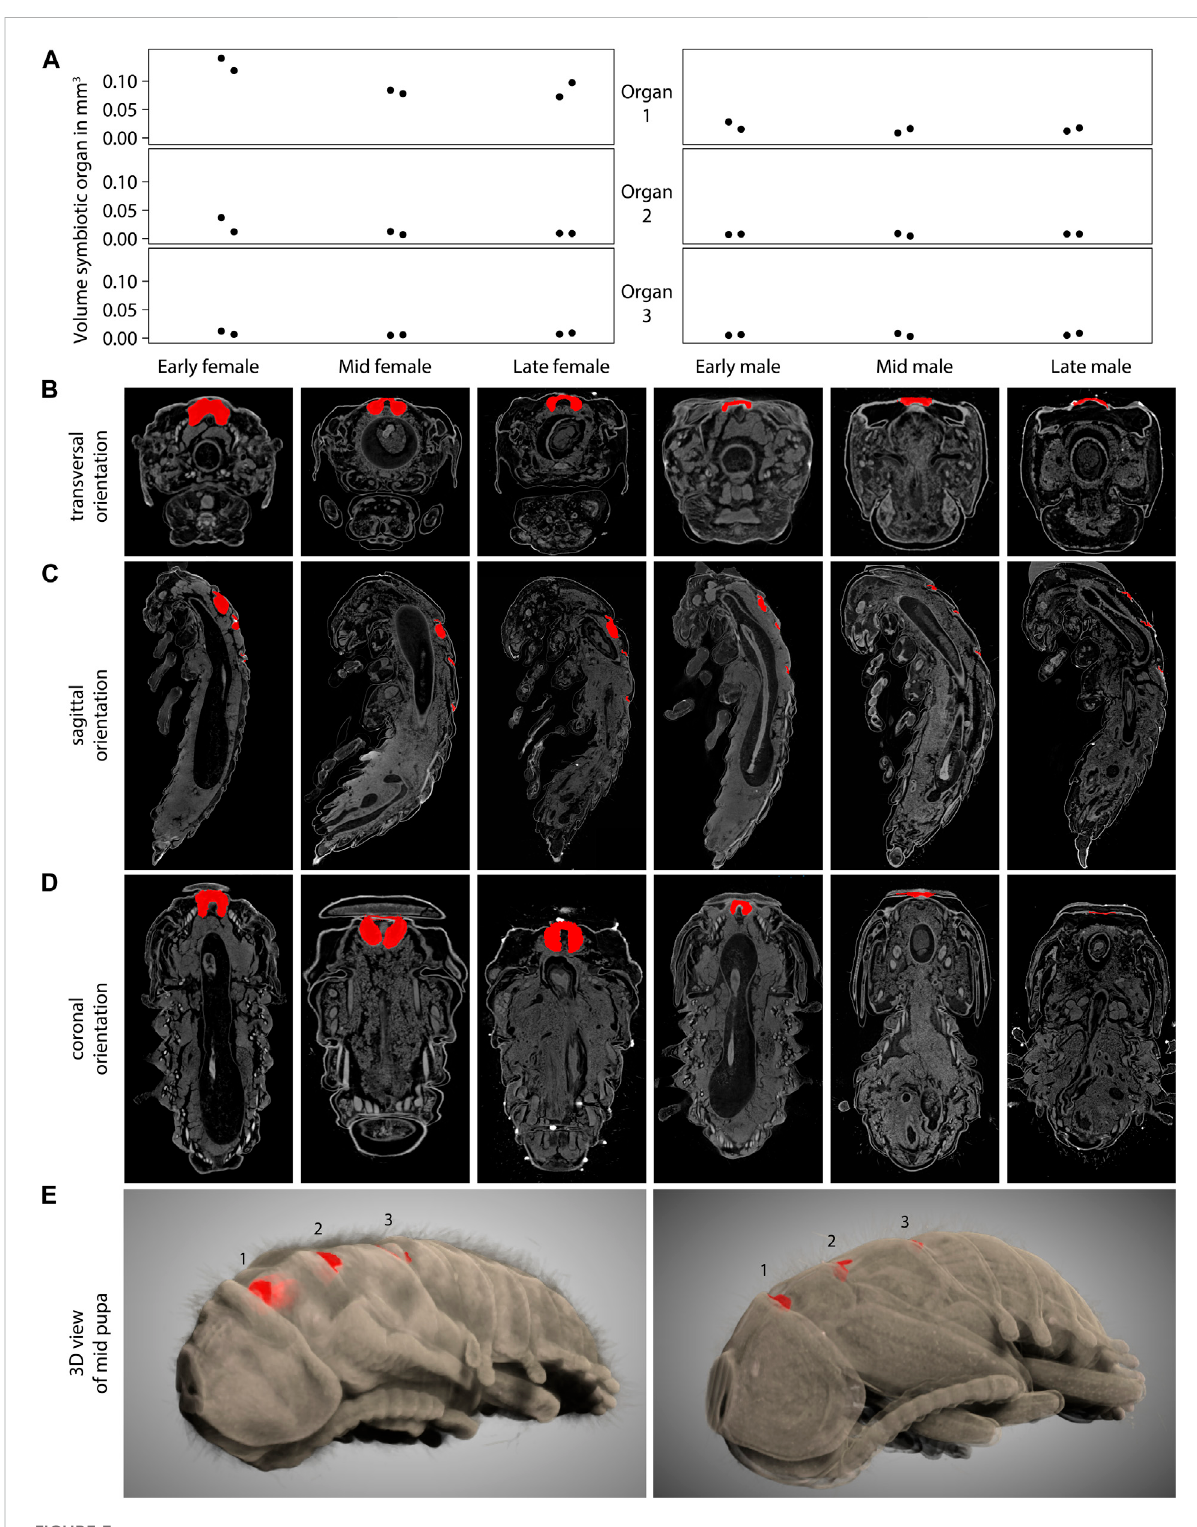
FIGURE 3 Symbiotic organs in female and male L. villosa across pupal development. (A) Volume of the symbiotic organs or cuticular structures measured from 3D µCT scans of L. villosa pupae of different sexes and stages. Female samples are shown on the left panels and males on the right. (B – D) Images show single sections in (B) transversal, (C) sagittal, and (D) coronal orientations through specimen (from left to right: early, mid and late female; early, mid, and late male pupa) corresponding to the columns in (A) . Cuticular structures are labeled in red and show the fi rst organ in transversalandcoronalsections,andallthreestructuresinsagittalsections. (E) 3Drepresentationofafemale(left)andmale(right)midpupashowing the cuticular structures in red within the dorsal